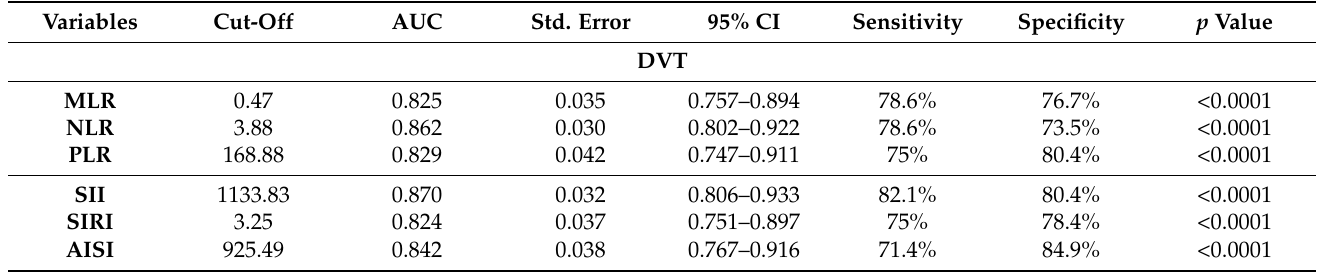
Figure 1. ROC curve analysis concerning DVT risk ( A ) for the MLR (AUC: 0.825; p < 0.0001), ( B ) for the NLR (AUC: 0.862; p < 0.0001), ( C ) for the PLR (AUC: 0.829; p < 0.0001), ( D ) for the SII (AUC: 0.870; p < 0.0001), ( E ) for the SIRI (AUC: 0.824; p < 0.0001), and ( F ) for the AISI (AUC: 0.842; p < 0.0001). Table 2. AUC of the ROC curve, 95% confidence interval, sensitivity, and specificity of the pre- operative inflammatory markers.